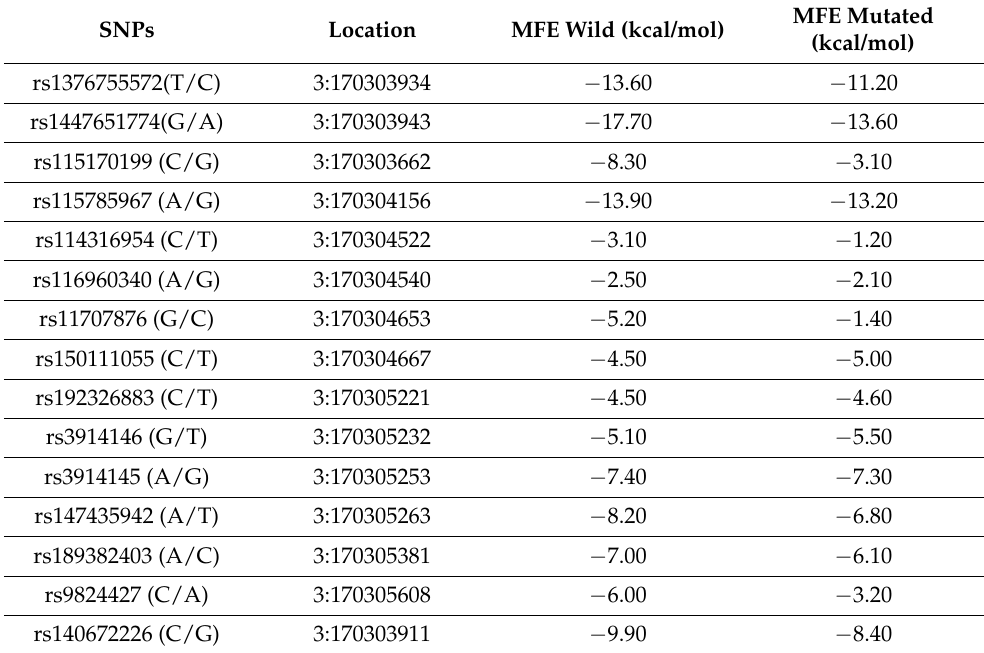
Table 4. Minimum free energy (MFE) of wild and mutant structures of mRNAs caused by 3 (cid:48) UTR